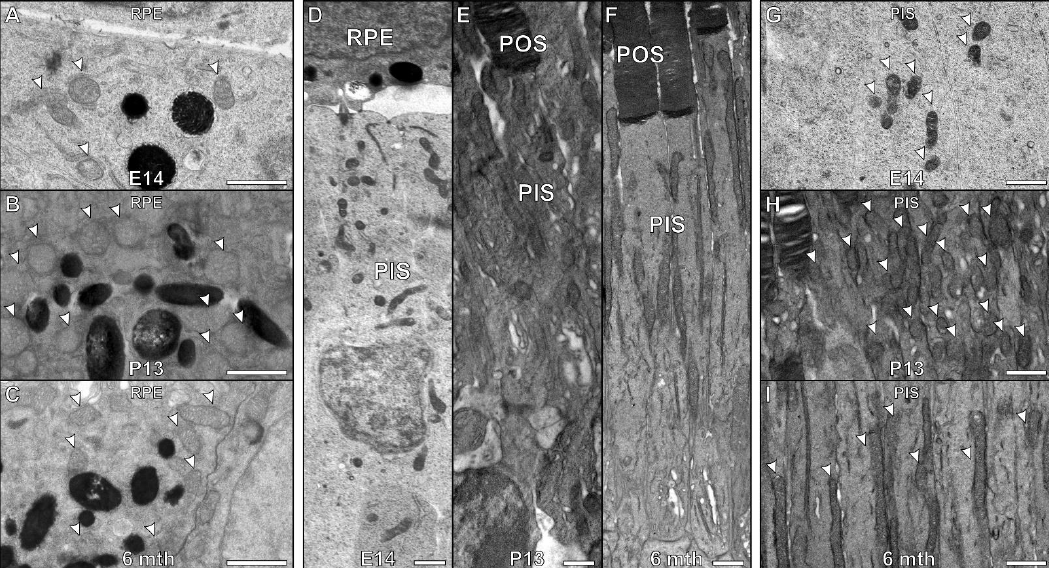
Figure 5. Age-related changes in mitochondrial size in zebrafish are not replicated in developing mouse retinas. ( A – C ) There is little difference between the mitochondria within the RPE at ( A ) em- bryonic day 14 (E14) compared to a ( B ) postnatal day 13 (P13) and ( C ) 6 month old mouse ( D – F ) By E14, mouse retina is still developing and photoreceptors do not have fully formed outer segments (POS). At P13, the mouse has photoreceptors with almost fully developed POS. ( G – I ) There is a clear difference in the photoreceptor inner segment mitochondria. ( G ) The mitochondria are smaller at E14 compared to ( H ) P13 and ( I ) 6 month old mouse. At P13, the appearance of the (B) RPE and (E, H) photoreceptors are similar to ( C , F , I ) at 6 months in adult mice. Scale bars ( A – I ) 1 µm .